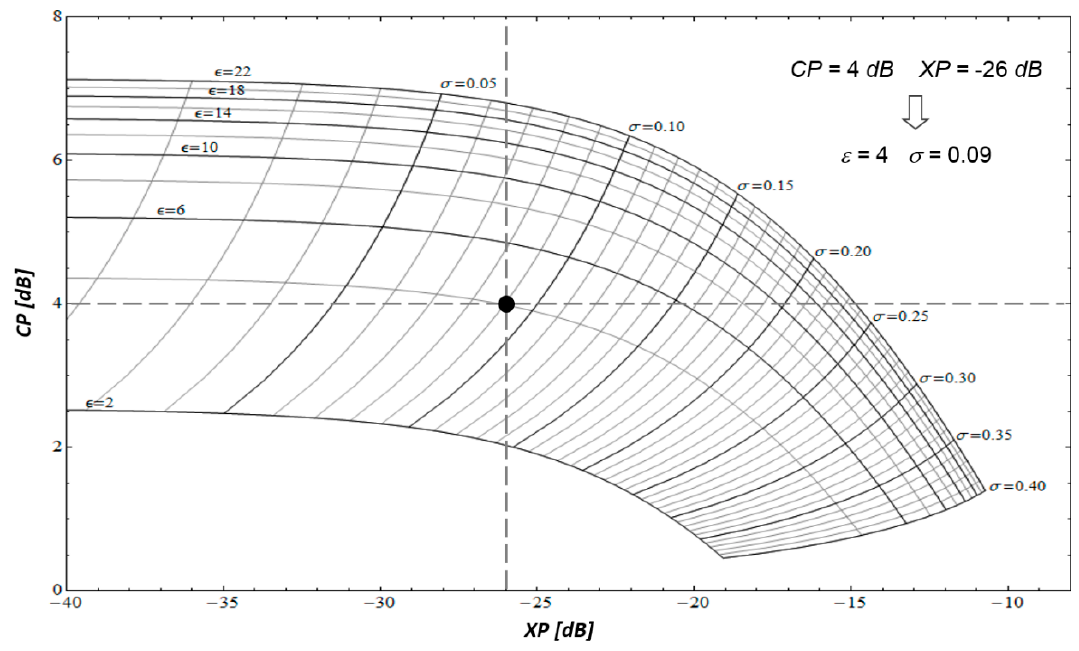
Figure 3. Co-pol/Cross-pol chart (radar look-angle equal to 45°) based on the PTSM approach and its usage for the soil permittivity and large-scale roughness retrieval: measured co-pol and cross-pol ratios equal to 4 dB and − 24 dB, respectively, lead to soil permittivity and soil roughness estimates equal to 4 and 0.09, respectively.